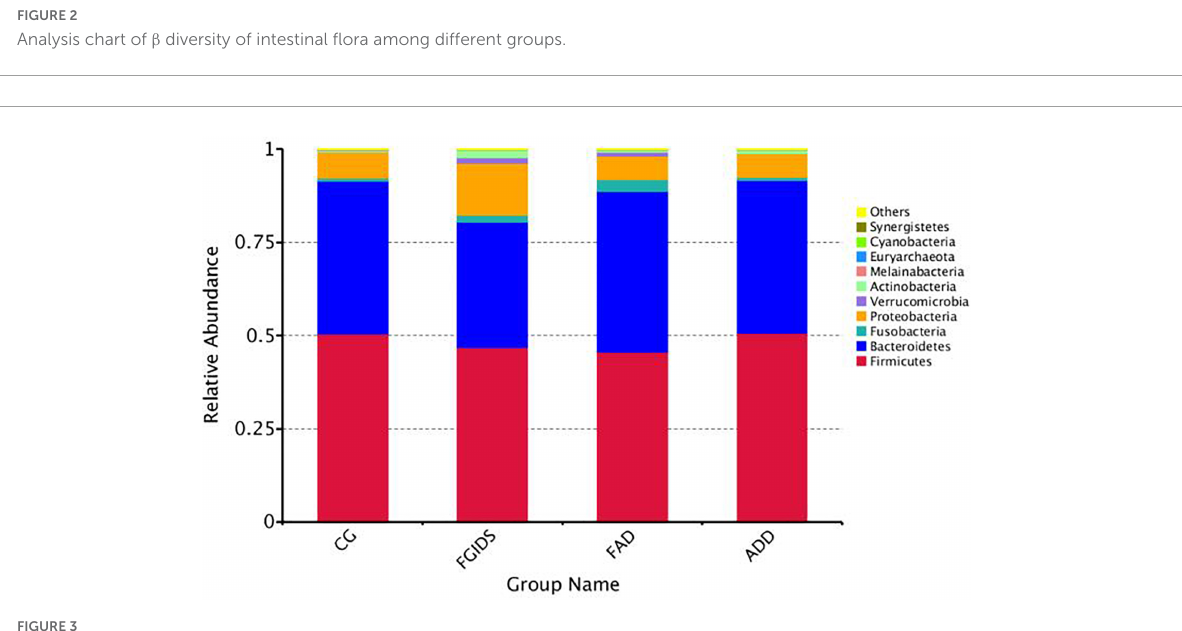
FIGURE3 Phylum level species stack